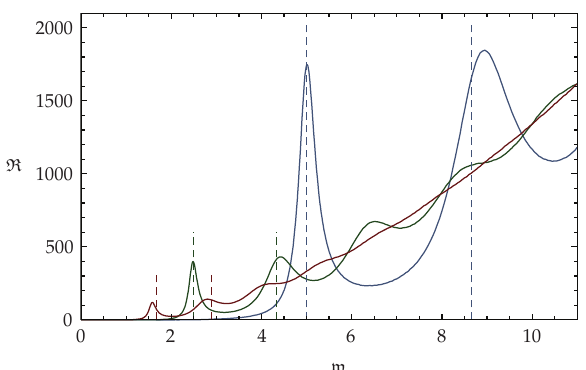
(cid:11) d (cid:5) 1—blue line,